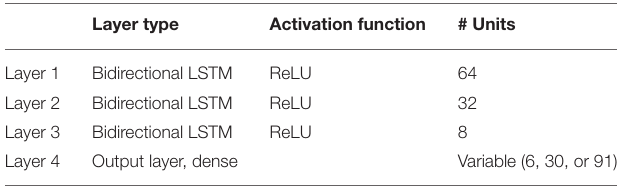
TABLE 3 | Description of the four layer model architecture used to fill temperature